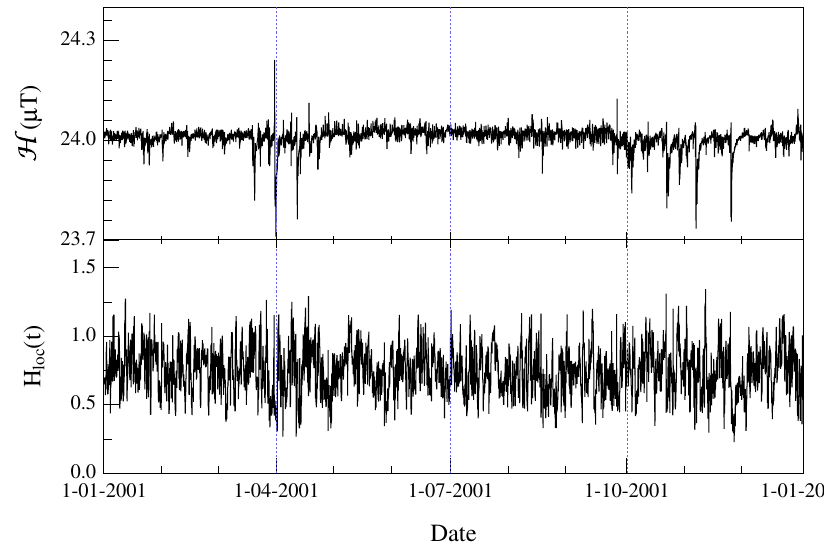
Fig. 10. The geomagnetic field H component, as measured at L’Aquila Geomagnetic Observatory (Italy) in 2001 (upper panel), and the corresponding local Hurst exponent H loc (t) (lower panel), computed using the DMA technique.